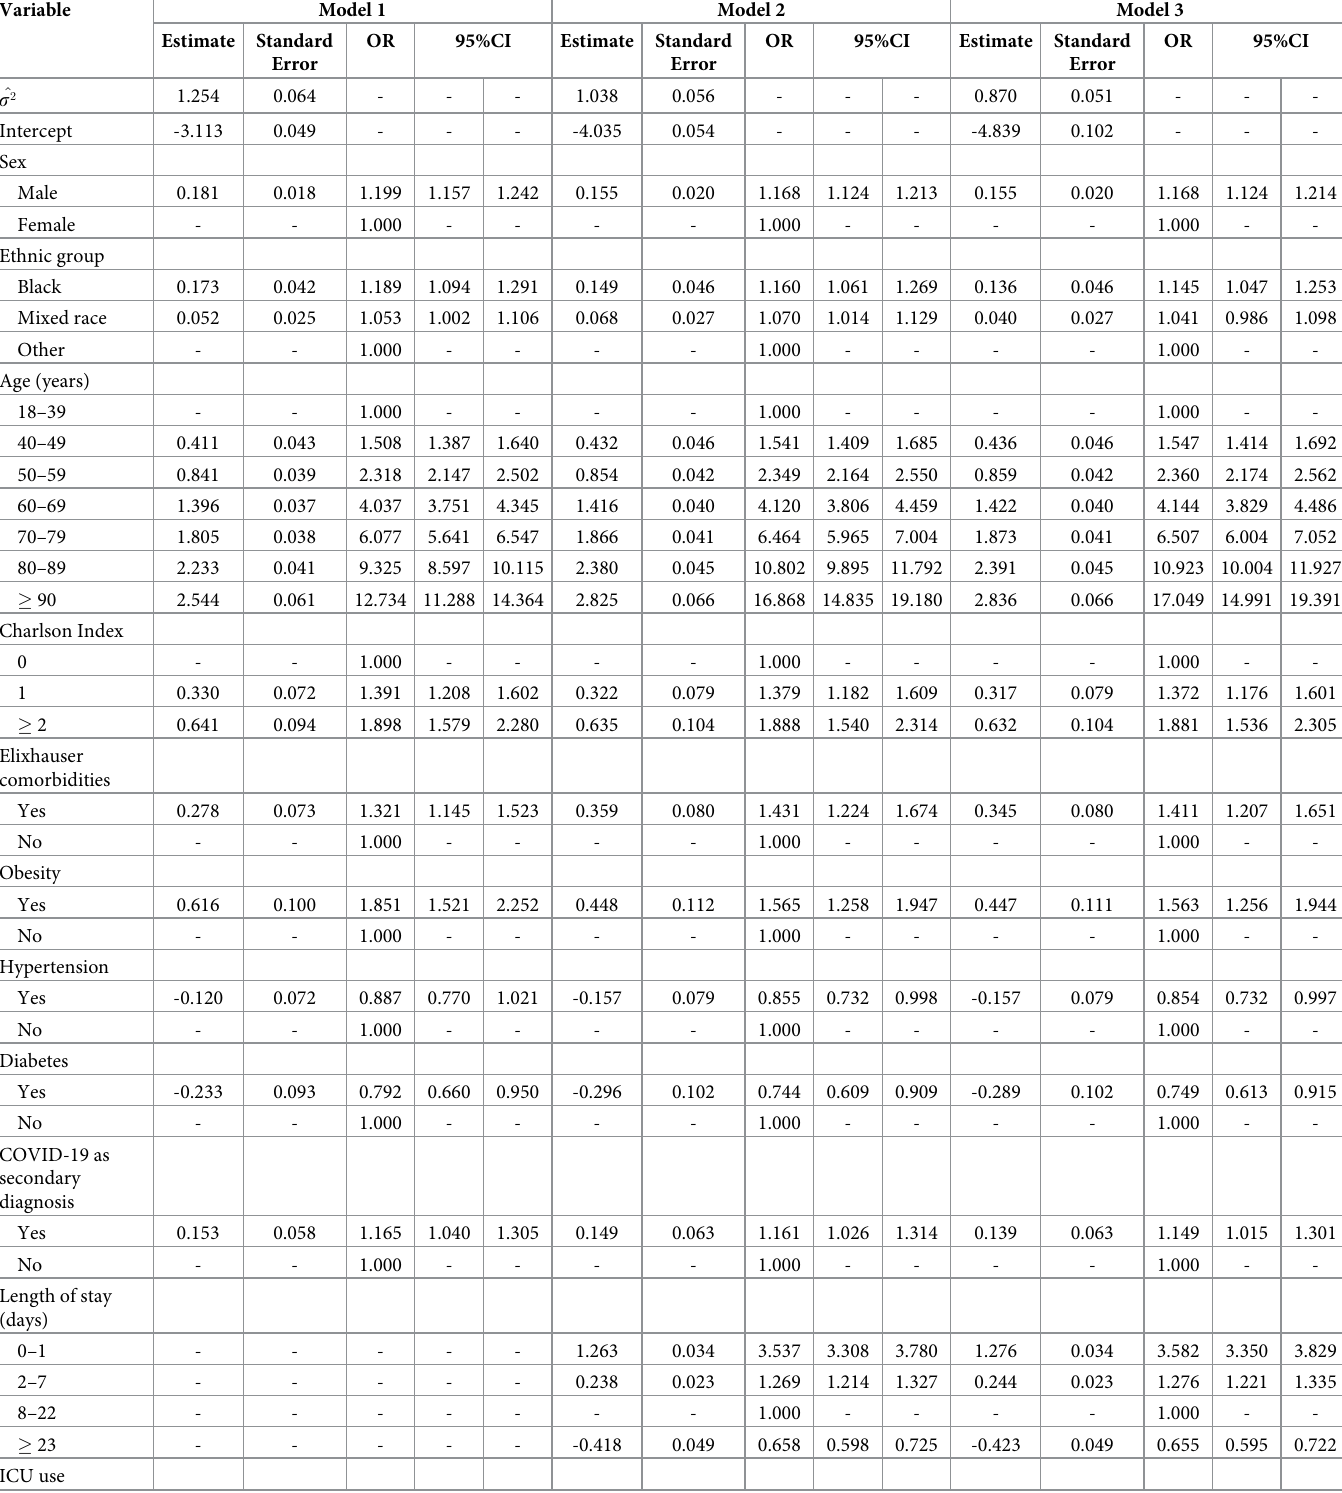
Table 4. Logistic regression models with the factors associated with the variation in in-hospital mortality in COVID-19 hospitalizations in the Unified Health Sys- tem (N = 89,405). Brazil, February to June